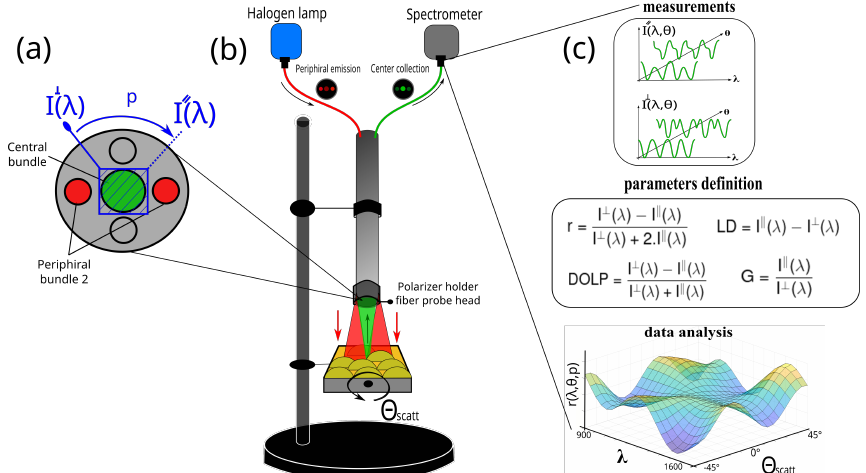
Figure 1. ( a ) Front view schematics of the optical fiber probe head and the polarizer rotation holder. ( b ) Schematics of the experimental in situ setup in DRS architecture. The red-line optical path is emitted from the halogen lamp to the sample and the green-line optical path is the collected backscattered light to the spectrometer. ( c ) Data analysis workflow of the multiparametric approach. I (cid:107) ( λ , θ ) and I ⊥ ( λ , θ ) are the projected collected scattered polarization states; θ scatt is the scattering angle obtained from the sample placed on a manual rotation holder, with − 45° and +45° (step 5°) range; r , LD , DOLP , and G are the anisotropy ratio, the linear dichroism, the degree of linear polarization, and the grating factor,